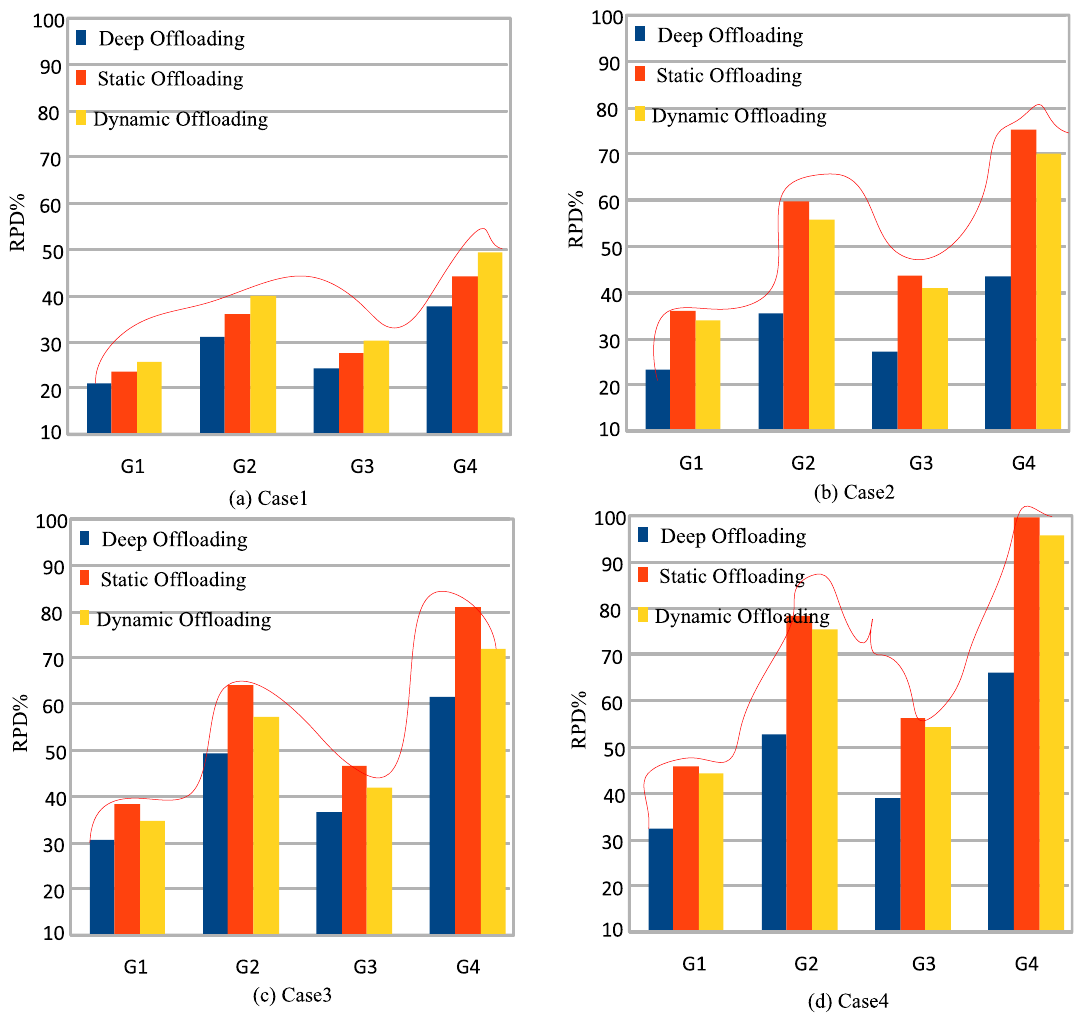
Figure 3. Blockchain enabled validation performance in multi-agent cooperative